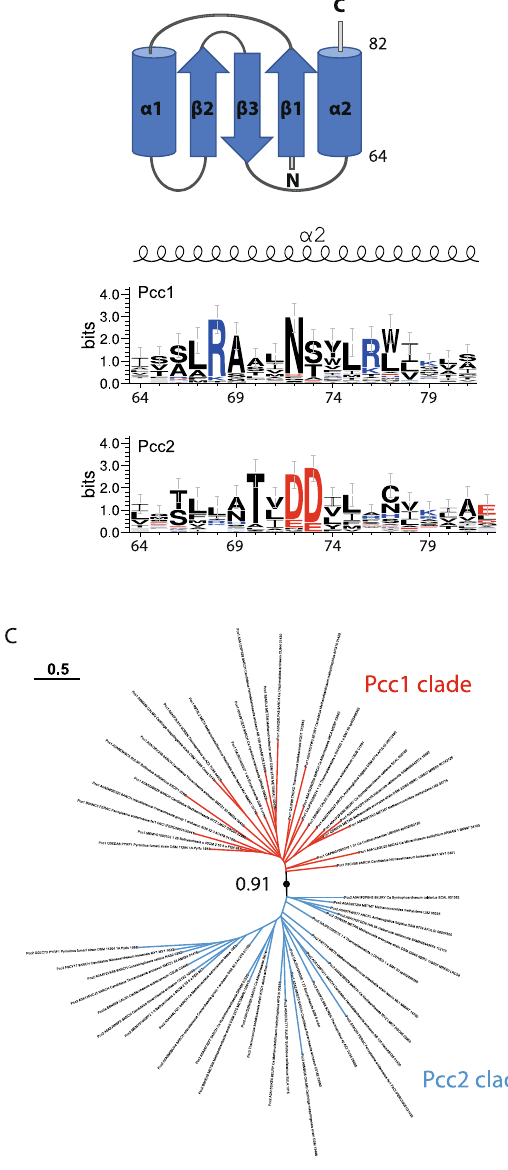
Fig. 2 | Identi fi cation of Pcc2 proteins in archaea. A Prevalence of Pcc1 and Pcc2 encoding genes among archaeal phyla. Number of identi fi ed Pcc1 or Pcc2 proteins is indicated in the corresponding columns. Full black circle corresponds to 100% and white circle to 0% of genomes containing both Pcc1 and Pcc2 encoding genes.